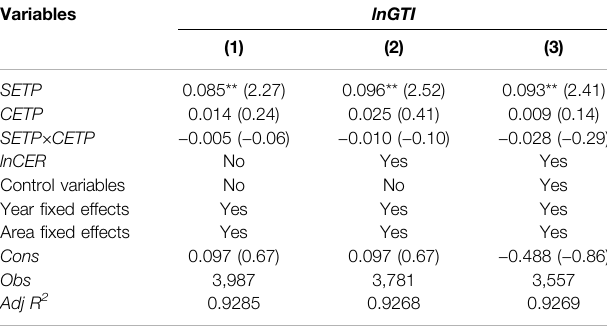
TABLE 4 | Estimation results of the combined effects model Variables